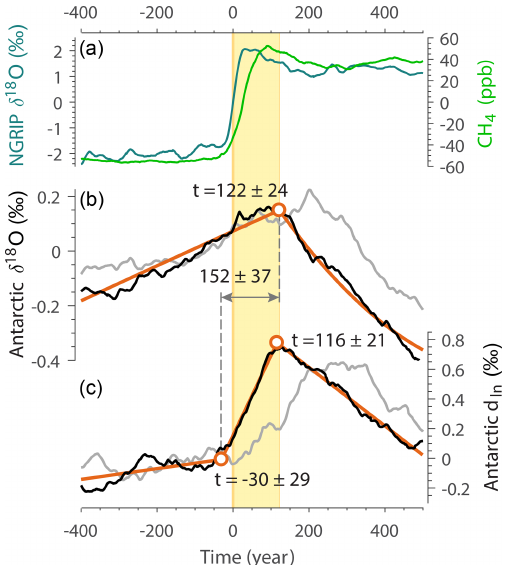
Figure 5. (a) Stack of Greenland NGRIP isotopes and CH 4 for the onsets of GI events listed in Table 1a. (b) Antarctic five-core mean δ 18 O (stack of 5 × 21 warming events). Black curve is the same as “mean” in Fig. 4, centre; grey curve applies the bipolar methane synchronization of WAIS Divide Project Members (2015). (c) Antarctic five-core mean deuterium excess ( d ln ). Black curve is the same as “mean” in Fig. 4e, f; grey curve applies the bipolar methane synchronization of WAIS Divide Project Members (2015). Orange curves are fitting functions using the change-point analysis applied in WAIS Divide Project Members (2015). The stated 2 σ un- certainty estimates are obtained from a Monte Carlo sampling (see main text). When the same uncertainty estimate is made for the GI terminations (Fig. 4) the δ 18 O timing is at 101 ± 29 years, the d ln transition onset is at − 59 ± 58 years, and the d ln transition end is at 95 ± 34 years; the duration between the d ln onset and the δ 18 O change point is 160 ± 65 years. The earlier d ln onset for the GI ter- mination probably reflects the GI terminations being generally more gradual than the GI